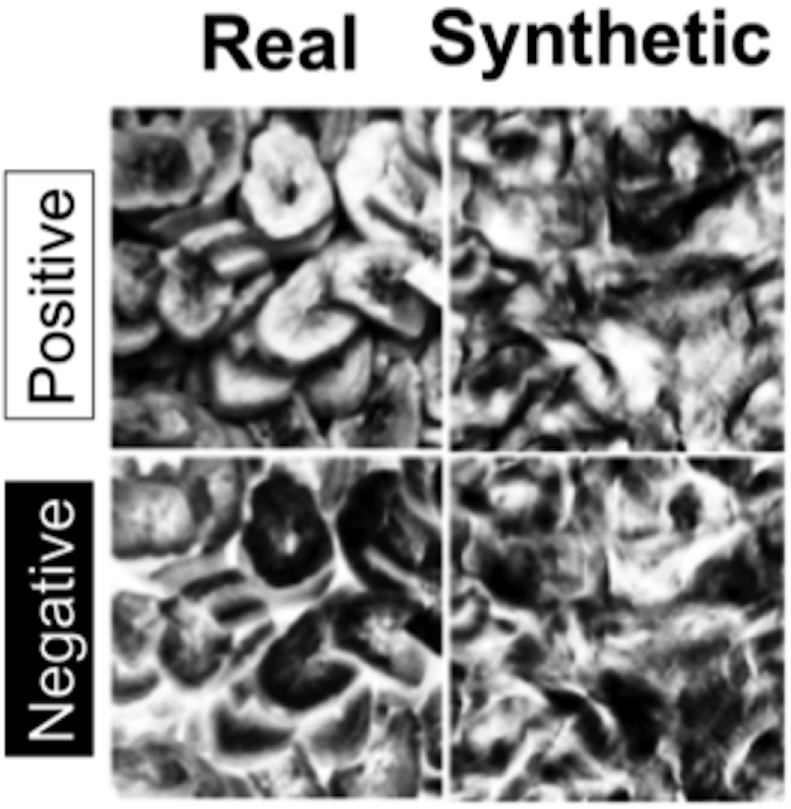
Fig 1. An example of a single original texture (upper left) and its synthetic counterpart (upper right), the original texture with contrast polarity reversed (lower left) and the result of applying both transformations (lower